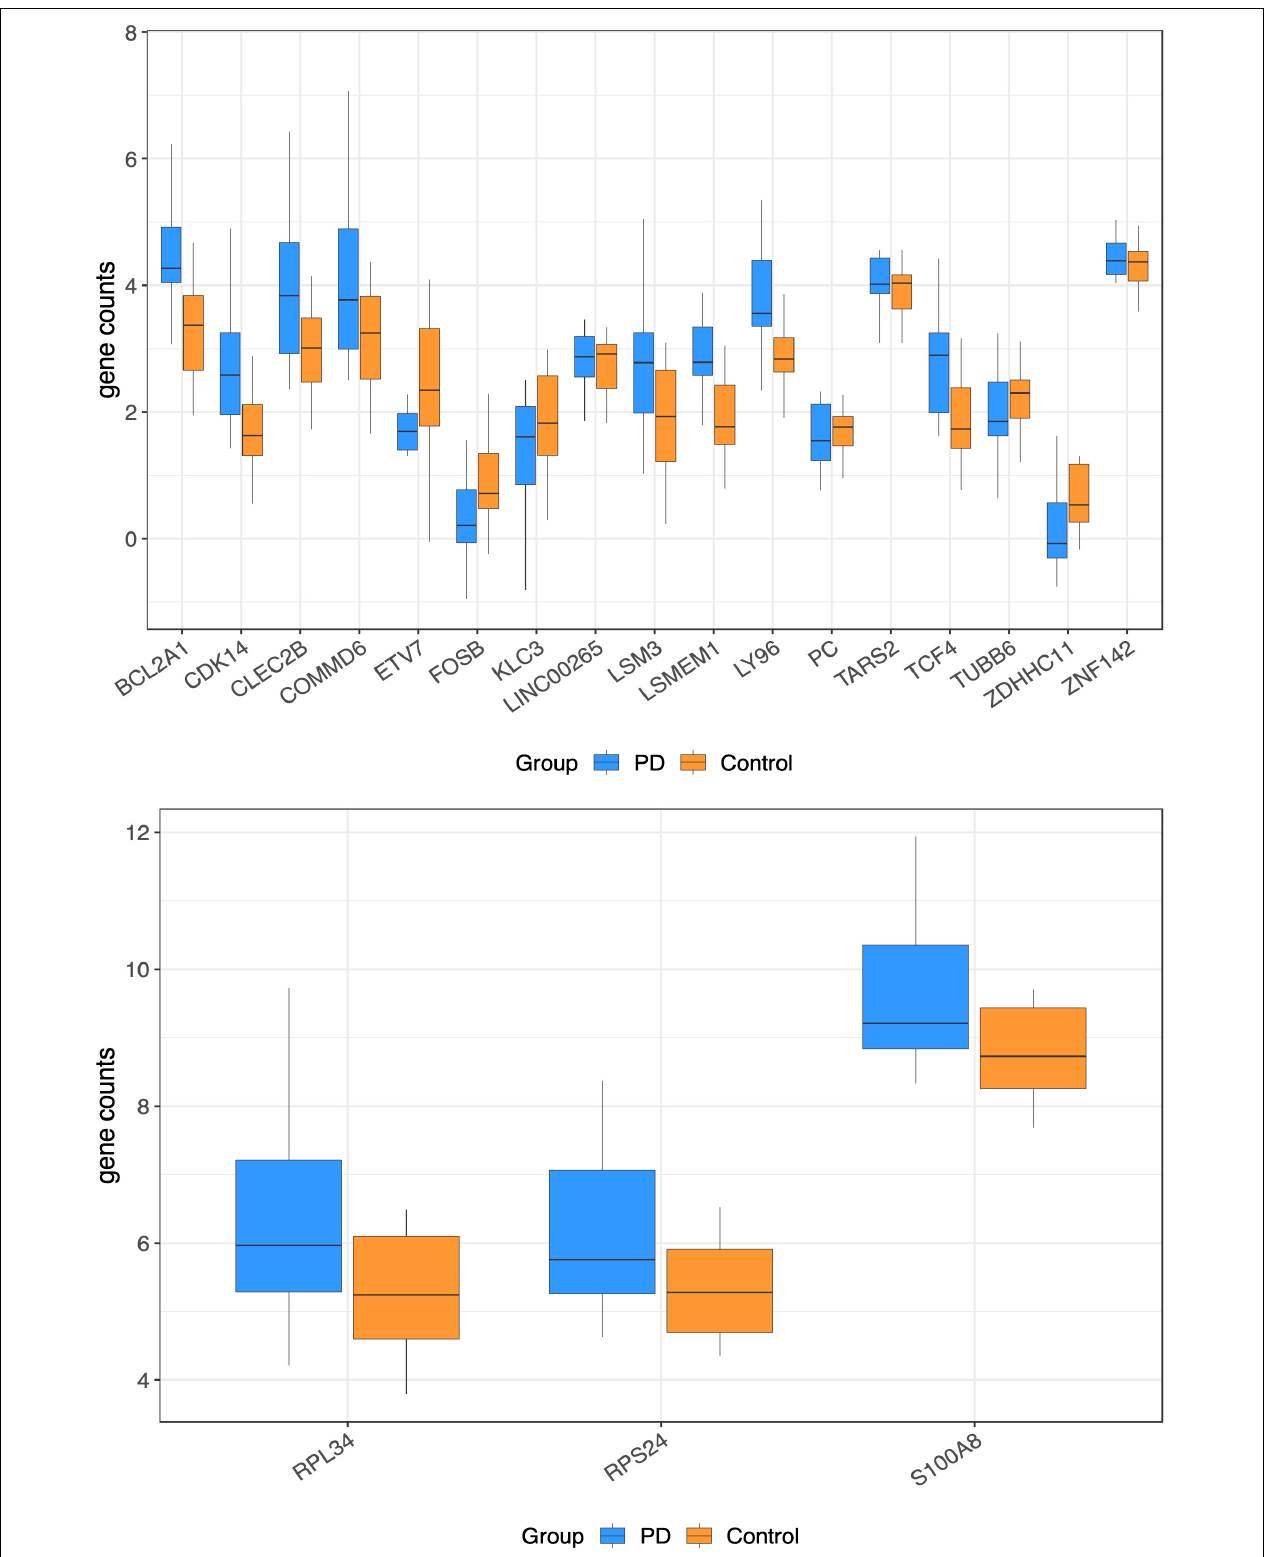
FIGURE 1 | Normalized gene counts for the top 20 genes significant differentially expressed genes (the plots were divided for clearer viewing).